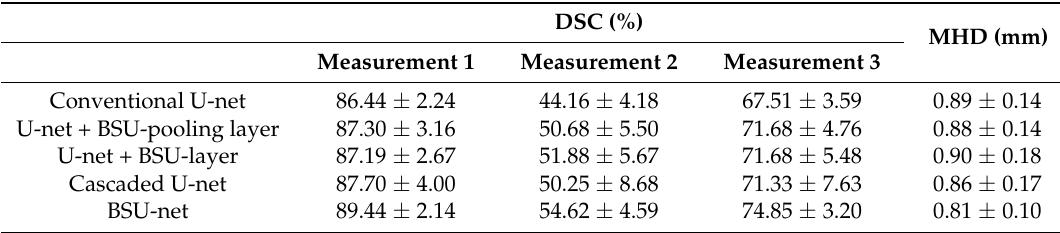
Table 3. DSC and MHD measurements for five different networks including conventional U-net, BSU- net and three different networks applying several components of BSU-net.